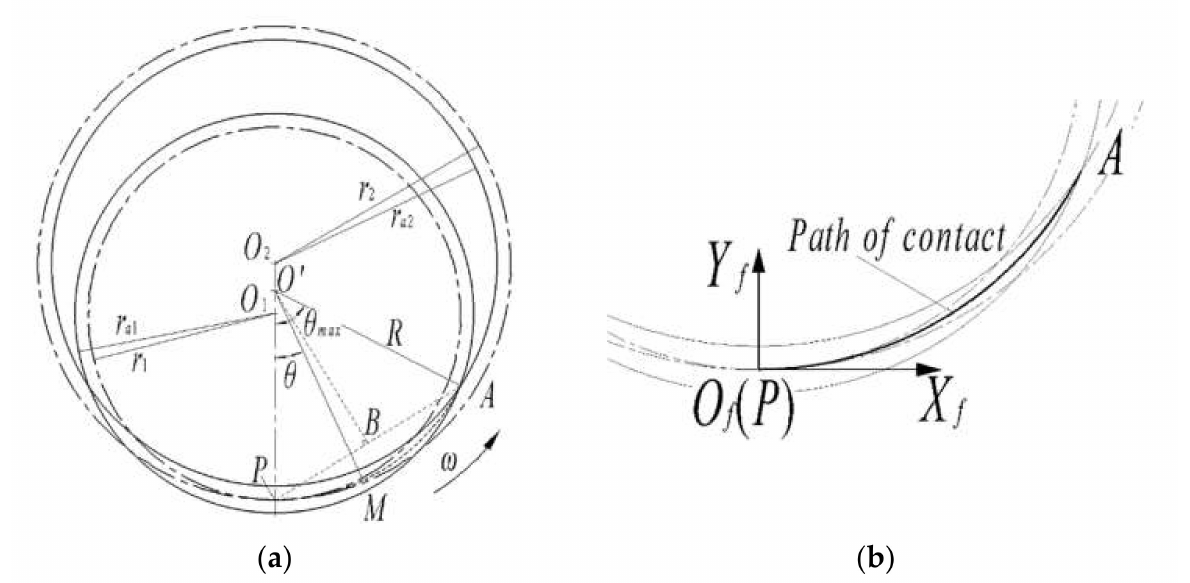
Figure 6. Path of contact of HCR internal spur gear drive: ( a ) global contact path; ( b ) enlarged contact